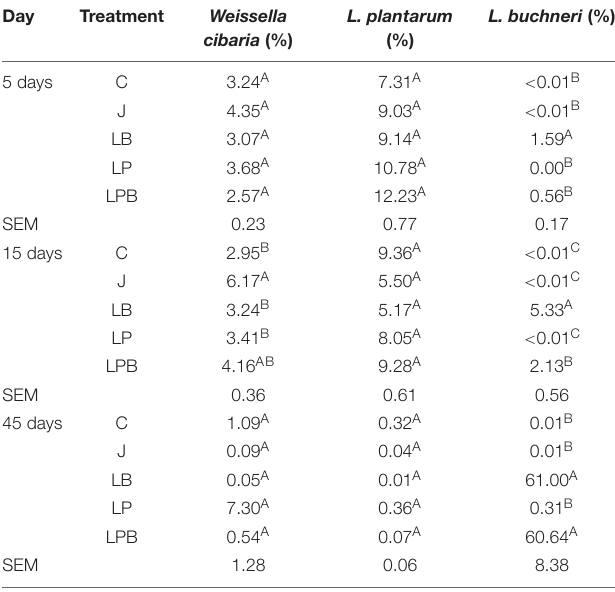
TABLE 5 | The succession of inoculations in a silage